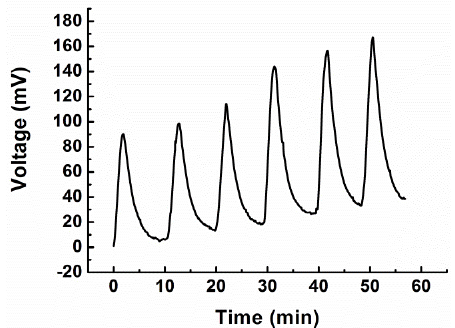
Figure 8. An actual sensor signal record for three determinations of 200 and 300 mg/L COD